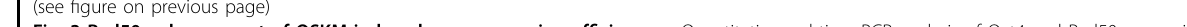
Fig. 3 Rad50 enhancement of OSKM-induced reprogramming ef fi ciency. a Quantitative real-time PCR analysis of Oct4 and Rad50 expression during OSKM-mediated somatic cell reprogramming. Data are expressed as the mean ± SEM. * p < 0.05 and ** p < 0.01, ANOVA with Tukey ’ s post hoc test. b Number of AP + colonies after OSKM-mediated somatic cell reprogramming. c Immunohistochemistry for Nanog (red), Oct4 (green), and DAPI (blue) following Rad50 overexpression or knockdown during OSKM reprogramming. d Quantitative real-time PCR analysis of pluripotent markers. Data are expressed as the mean ± SEM. ** p < 0.01, ANOVA with Tukey ’ s post hoc test. e Morphology and fl uorescence pro fi les of Oct4-GFP fi broblasts overexpressing Rad50. f The number of Oct4-GFP-positive colonies was counted during OSKM reprogramming. g Dot blot analysis of 5mC in diluted genomic DNA from cells exhibiting Rad50 overexpression or knockdown at day 15 during OSKM reprogramming. Data are expressed as the mean ± SEM. ** p < 0.01, ANOVA with Tukey ’ s post hoc test. The images ( c , e , and g ) are representative of ≥ 3 similar